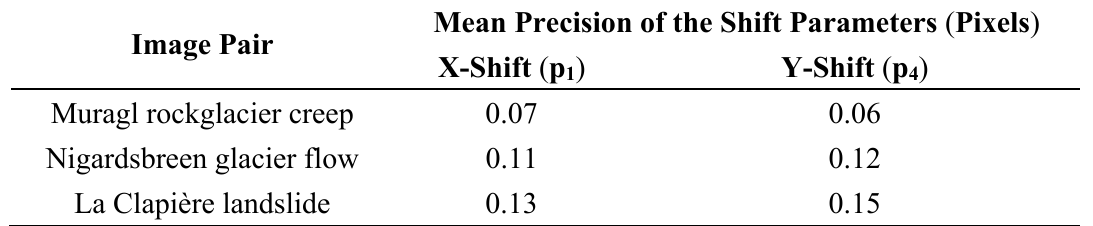
Table 3. Mean precision of the shift parameters for the three bi-temporal mass movement image